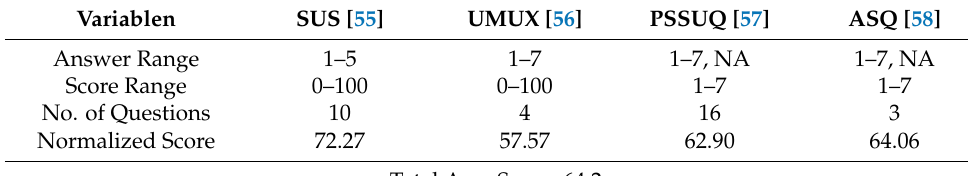
Table 3. Results of usability questionnaires.